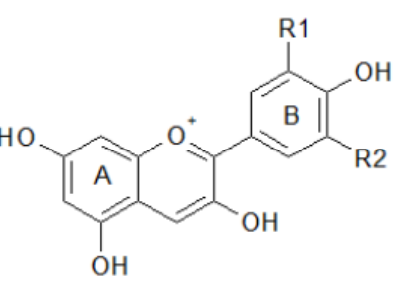
Figure 6. Anthocyanin